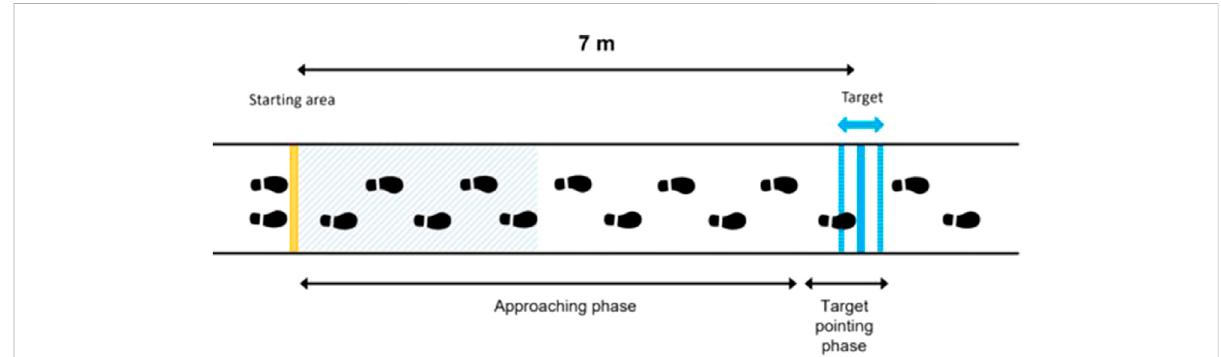
FIGURE 3 Diagram of the locomotor pointing task consisting of an approaching phase and a target-pointing phase. Participants were instructed to place themselves in the starting area and to start walking with the right leg. For each trial, participants were asked to place their right foot tip as close as possible to the lower extremity of the target while walking at a normal pace and continuing to walk subsequently. The position of the target was manipulatedunbeknownsttotheparticipants(3differenttargetpositions:0±20 cm).Thebluehatchedarearepresentstheareaforcalculating the average gait speed (i.e., the fi rst fi ve